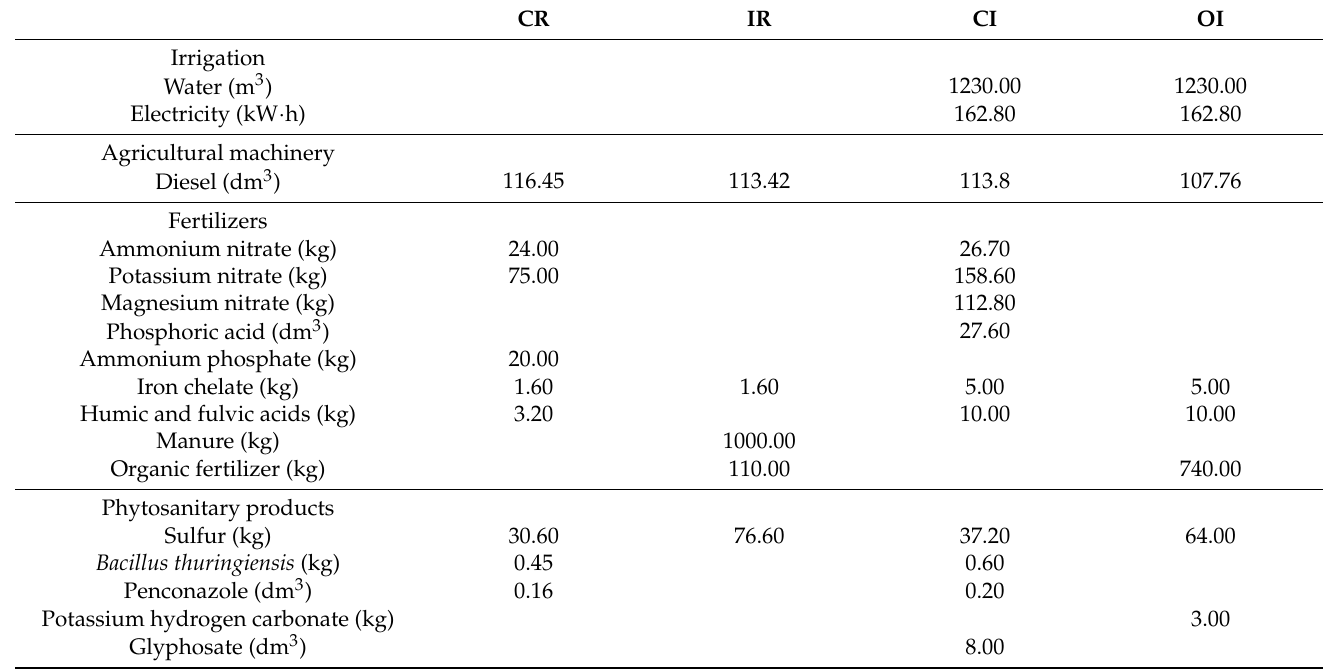
Table 2. Agronomic data of the four vineyard models (quantities per ha and year). CR: conventional rainfed; OR: organic rainfed; CI: conventional irrigation; OI: organic